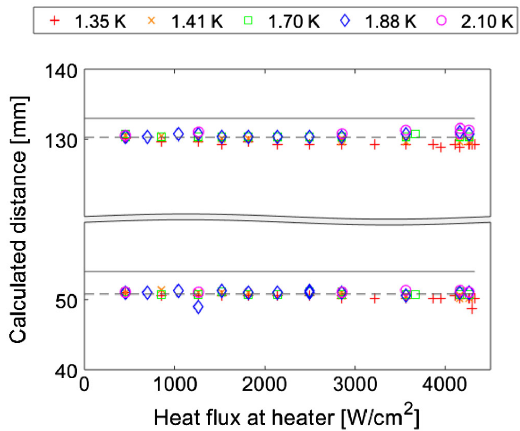
FIG. 14. Distances from heater to OSTs versus heat pulse energy, calculated from times of arrival and recommended second sound velocity. For each OST the measured distances is shown (solid